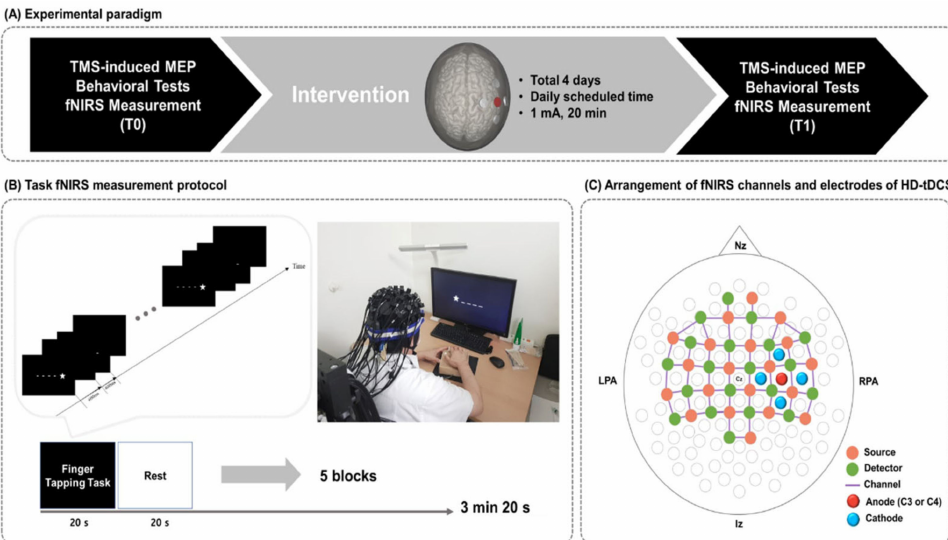
Figure 1. Study design. ( A ) Experimental paradigm. ( B ) fNIRS measurement during the FTT. A star appeared on the black screen for 600 ms, and then an empty black screen appeared for 400 ms after the star disappeared. Each subject pushed the corresponding buttons using fingers on the affected side. ( C ) Arrangement of fNIRS optodes and HD-tDCS electrodes. fNIRS, functional near- infrared spectroscopy; FTT, finger tapping task; HD-tDCS, high-definition transcranial direct current stimulation; Nz, nasion; Iz, inion; LPA, left pre-auricular; RPA, right